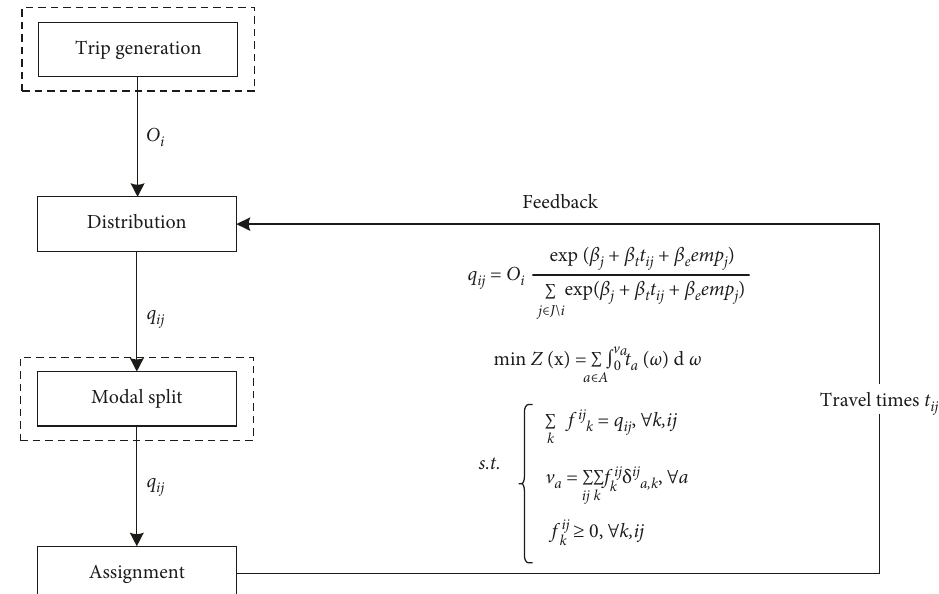
Figure 1: Feedback process of transportation system